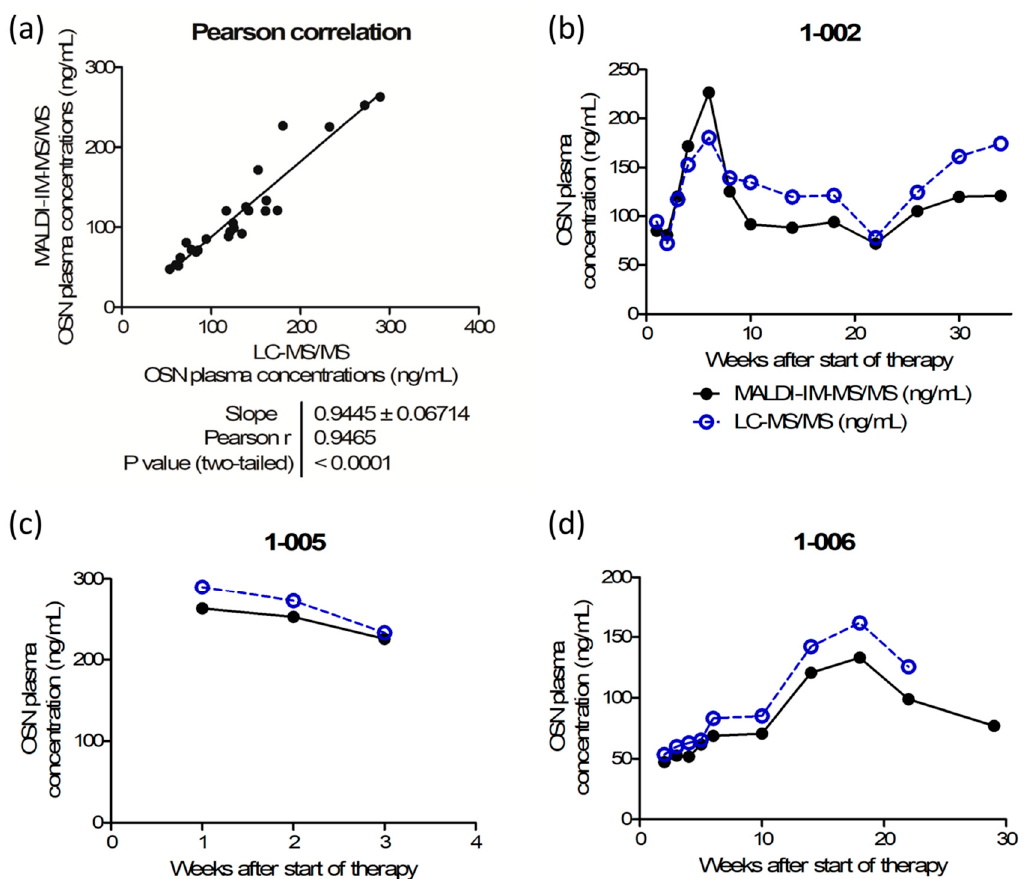
Figure 5. Cross-validation of the matrix-assisted laser desorption / ionization–ion mobility–tandem mass spectrometry (MALDI–IM–MS / MS) assay. ( a ) Pearson correlation of quantification results from clinical samples showing a significant correlation between the results obtained with the MALDI–IM–MS / MS and the liquid chromatography (LC)–MS / MS analytical methods ( r = 0.9465, p value < 0.0001). Evolution of osimertinib plasma concentration over the first weeks of therapy for three patients: ( b ) 1-002, ( c ) 1-005, and ( d ) 1-006 with MALDI–IM–MS / MS results displayed as full black circles and LC–MS / MS results displayed as empty blue circles.